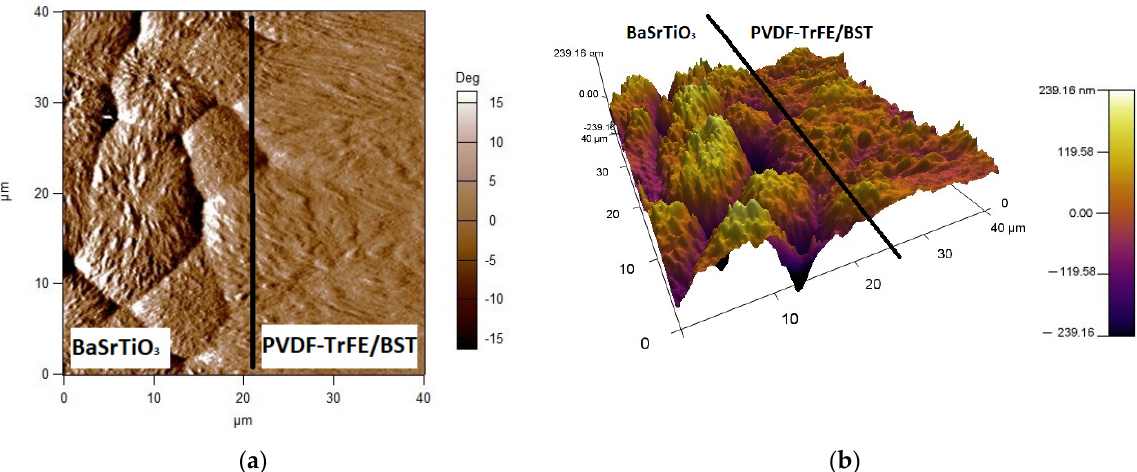
Figure 14. AFM images comparing the surface topography of BST film and PVDF-TrFE coated BST film: ( a ) 2D (top view); ( b ) 3D view of the same surfaces [36].